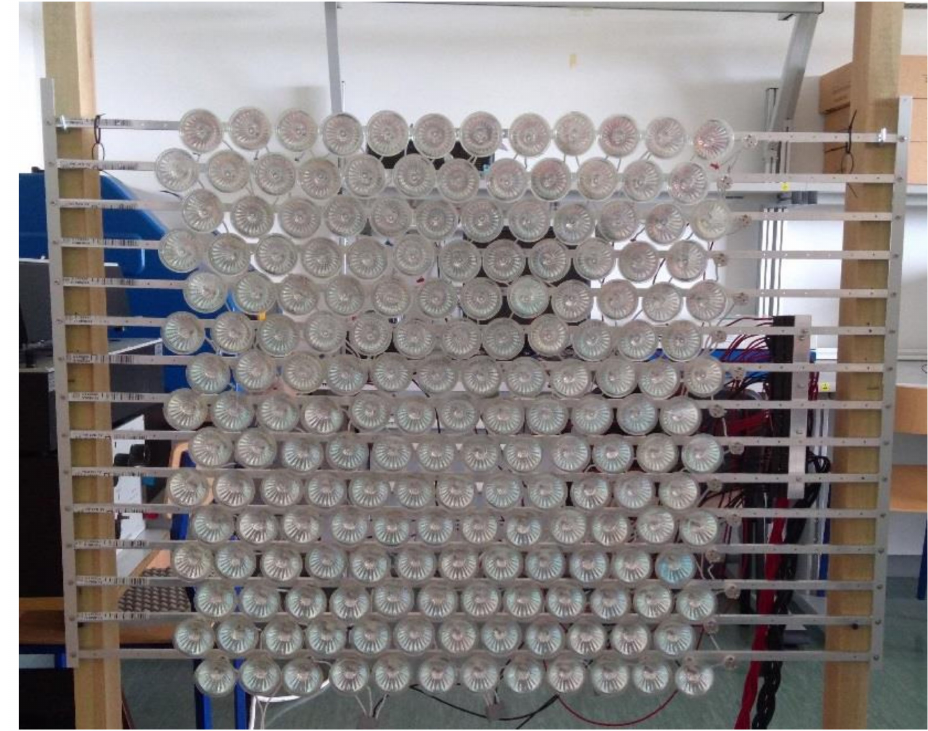
Figure A6. Halogen lamps used to illuminate the measured